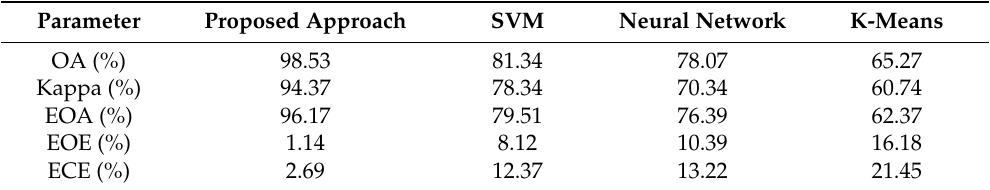
Table 4. Statistics of different cloud detection